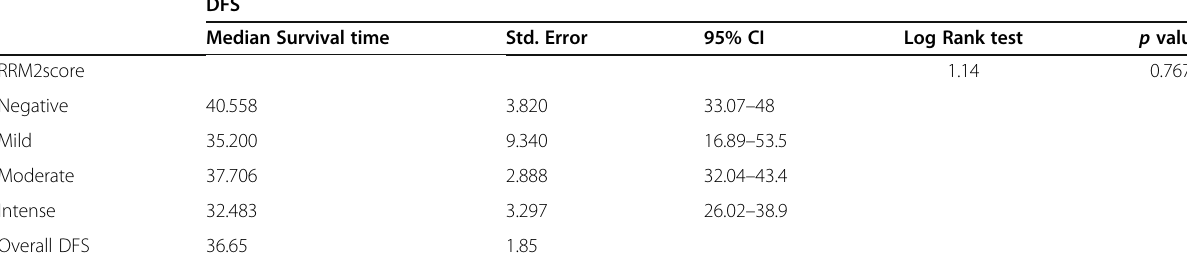
Table 3 Kaplan-Meier disease free survival for RRM2 score in whole